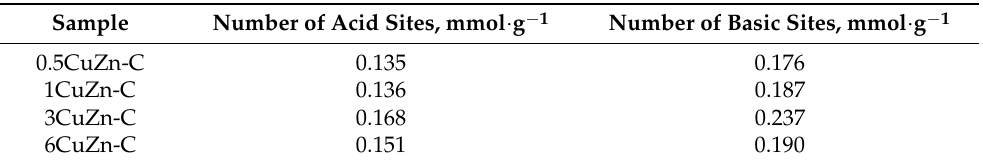
Table 2. The number of acid and basic sites determined from TPD profiles of adsorbed NH 3 and CO 2 , respectively.